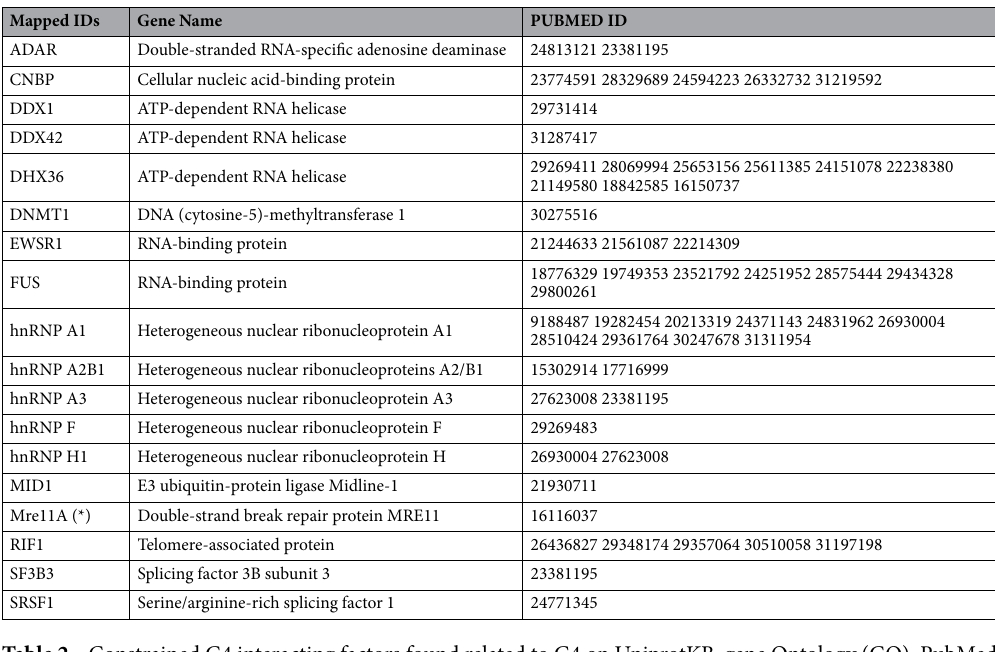
Table 2. Constrained G4 interacting factors found related to G4 on UniprotKB, gene Ontology (GO), PubMed abstract and G4IPDB 48 data bases.